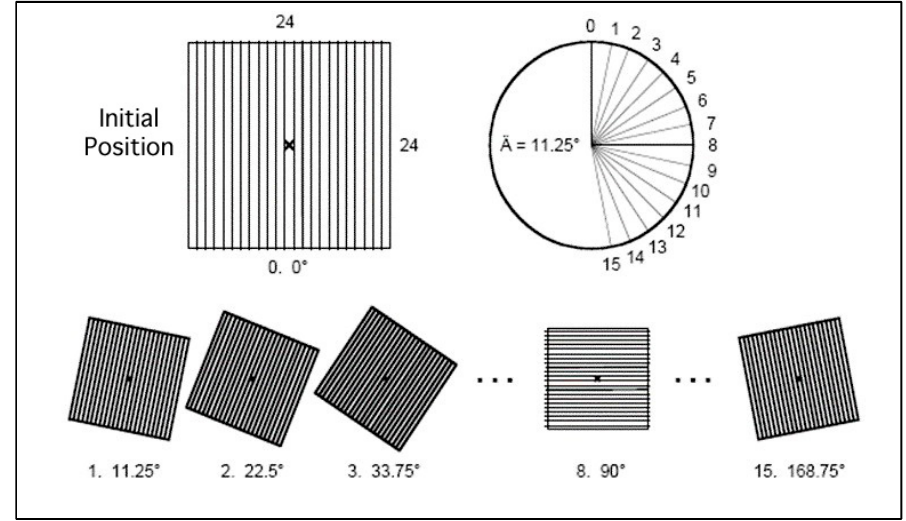
Figure 6. Ridge Flow Direction Calculation. Top left: 24 × 24 grid oriented 0°. Top Right: Rotational reference frame. Lower: Range of possible orientations separated by 11.25° [31,32].